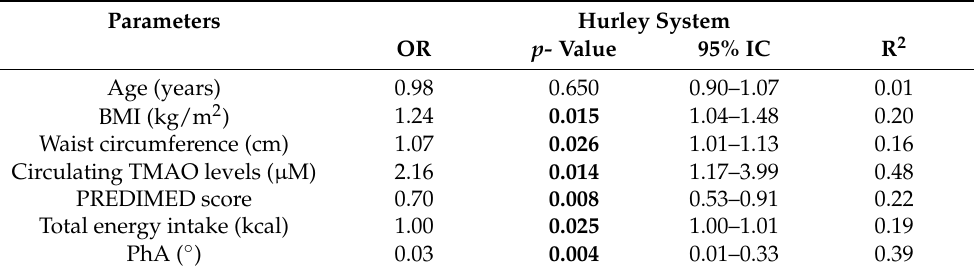
Table 4. Bivariate proportional odds ratio model to assess the association between Hurley system and age, BMI, waist circumference, circulating TMAO levels, PREDIMED score, total energy intake, and PhA. Parameters Hurley System OR p- Value